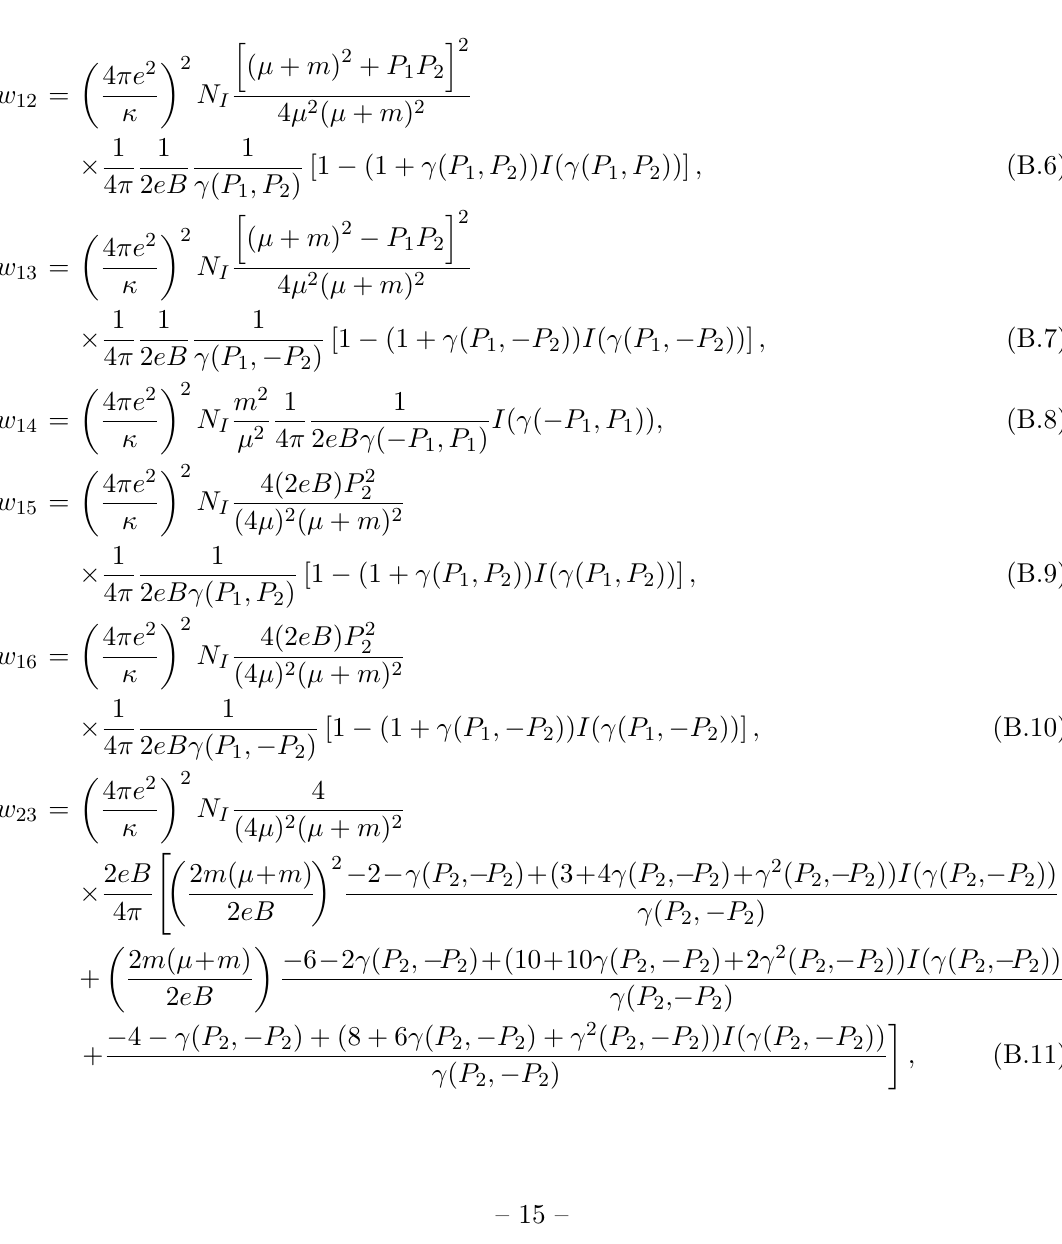
; p ) = (cid:22) , some 3 z